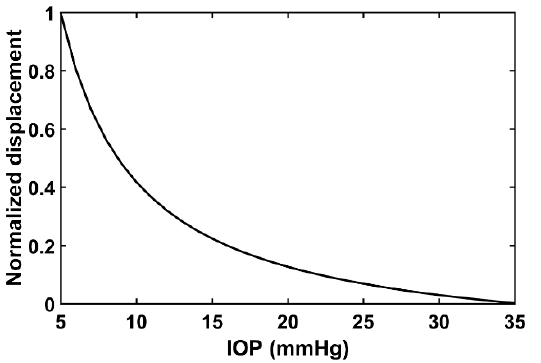
Figure 3. Relationship between normalized displacement obtained by Equation (8) with assumed values and desired IOP range.